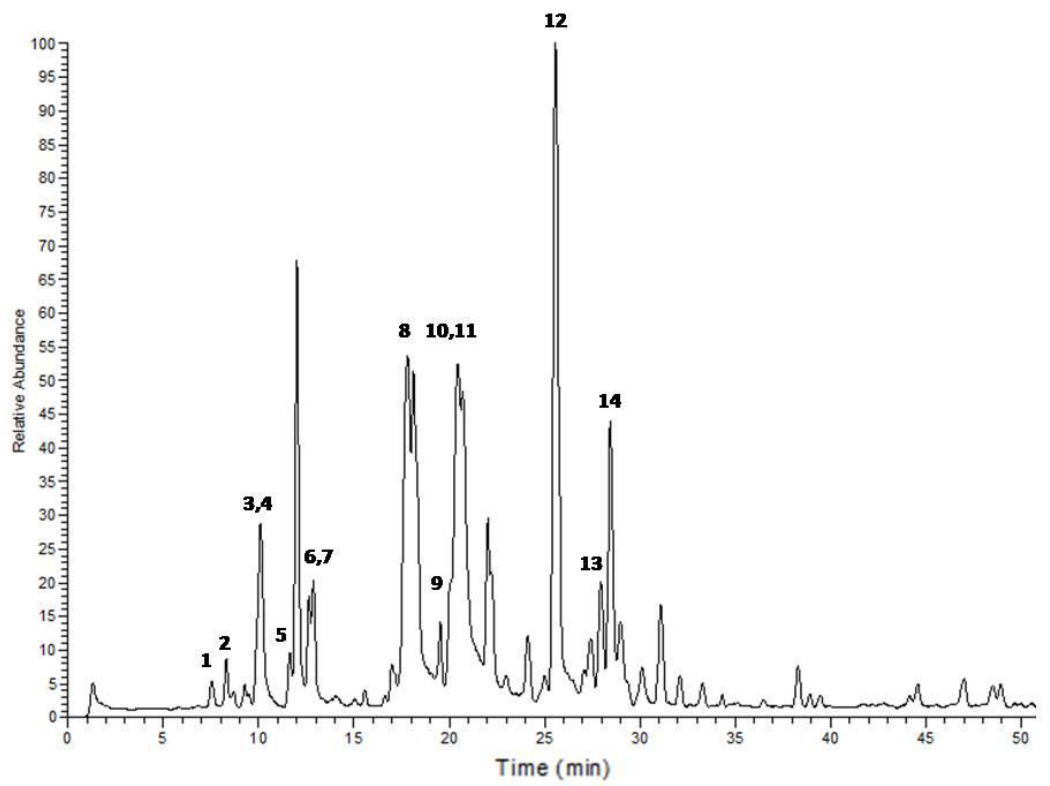
Figure 3. LC-ESI-MS/MS profile of the dichloromethane extract from Allium sativum . Peak numbers correspond to compounds listed in Table 1.